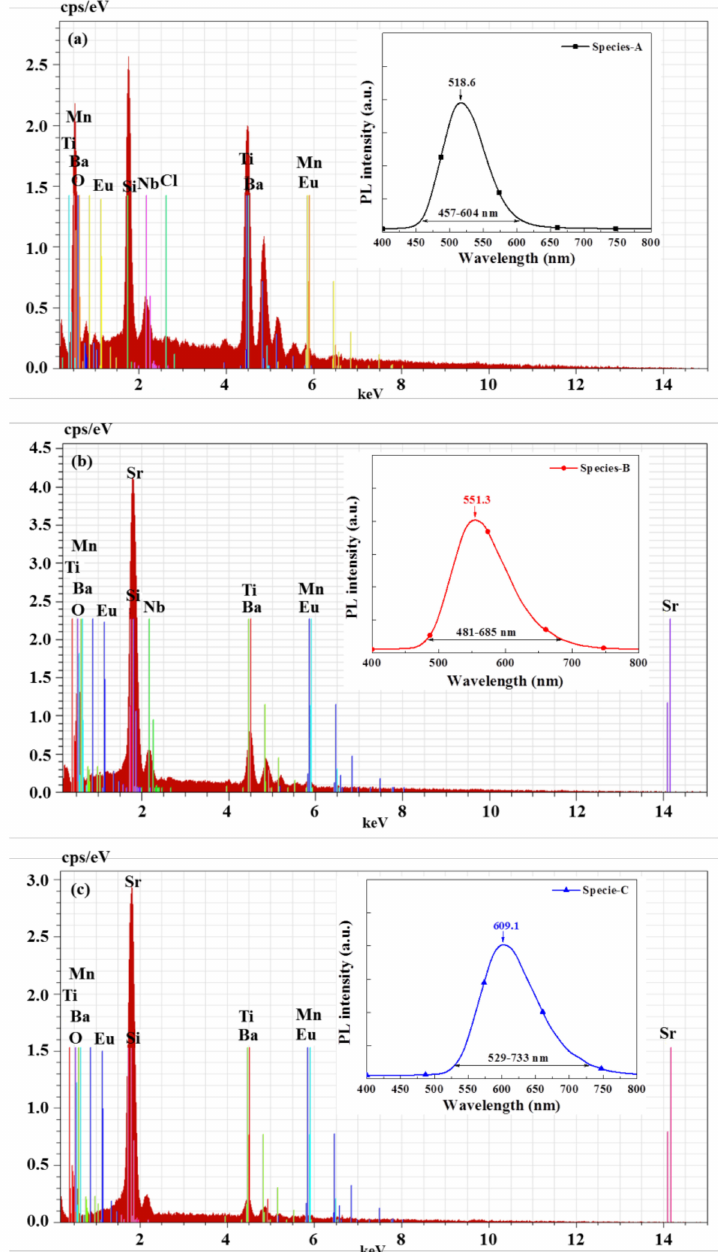
Figure 2. Energy-dispersive X-ray spectroscopy (EDS) spectra and fluorescence emission spectra of silicon samples coated with SiO 2 layer comprising ( a ) specie-A; ( b ) specie-B; or ( c ) specie-C of Eu-doped silicate